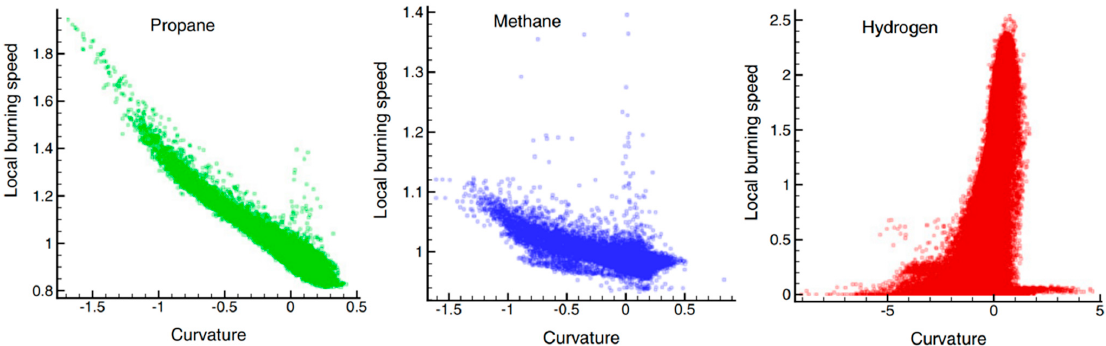
Figure 33. Correlation of local burning speed with curvature for each flame. Flame speeds are normalized to the corresponding laminar burning speed, and curvature is normalized with the laminar flame thermal thickness.